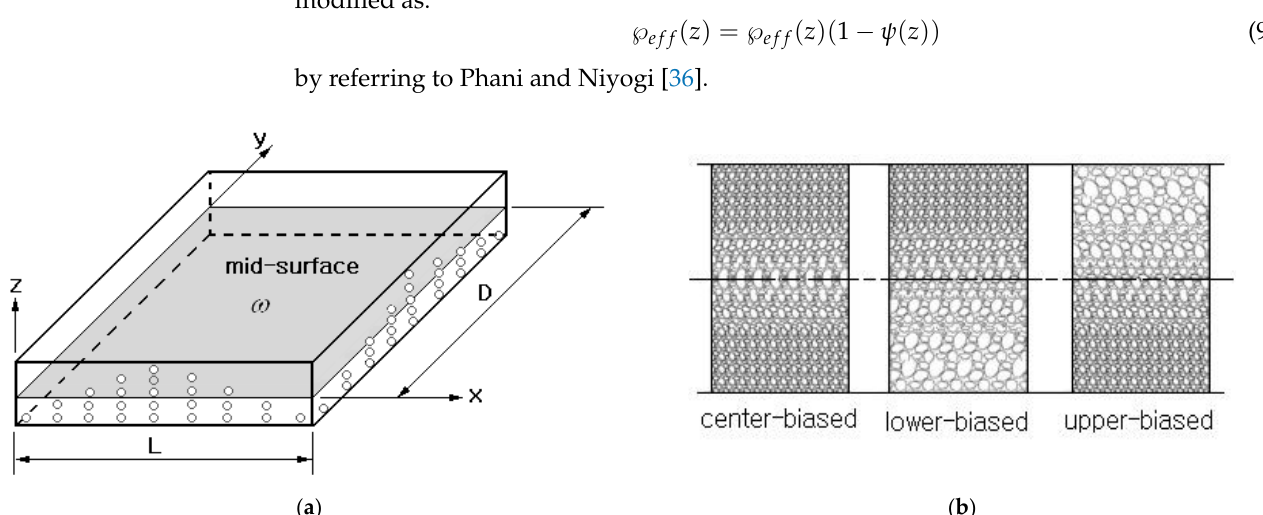
Figure 2. FG-porous CNTRC plate: ( a ) thickness-wise porosity gradient, ( b ) three different porosity distributions.